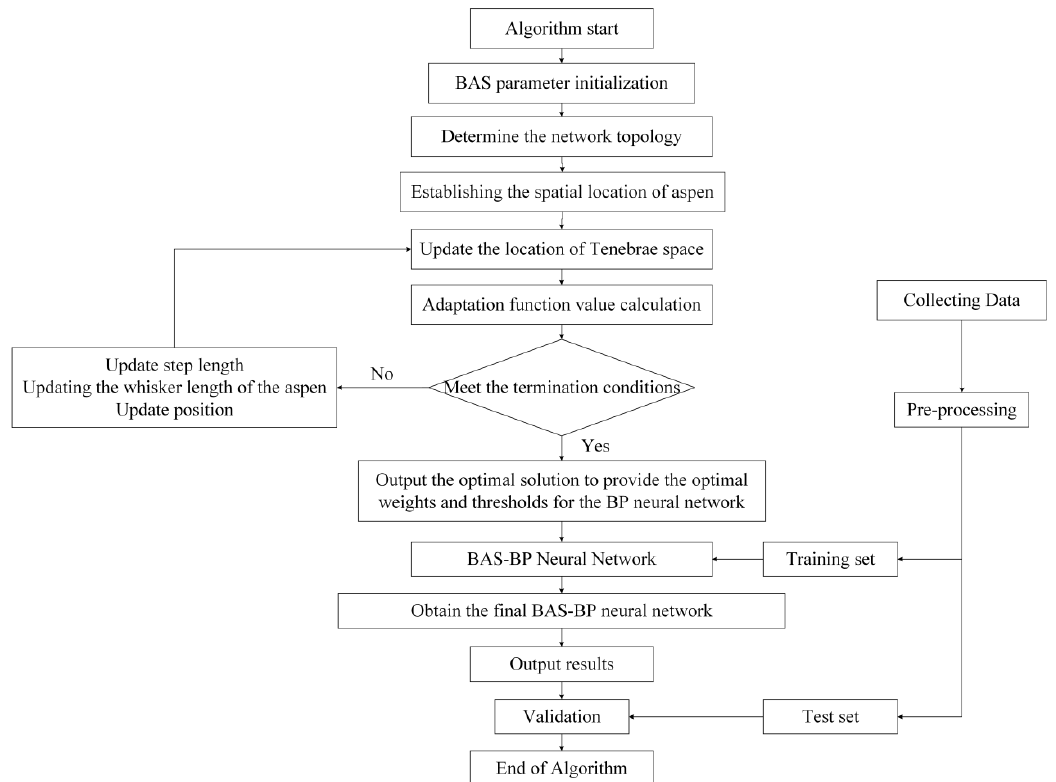
Figure 3. BAS-BP algorithm flow chart.